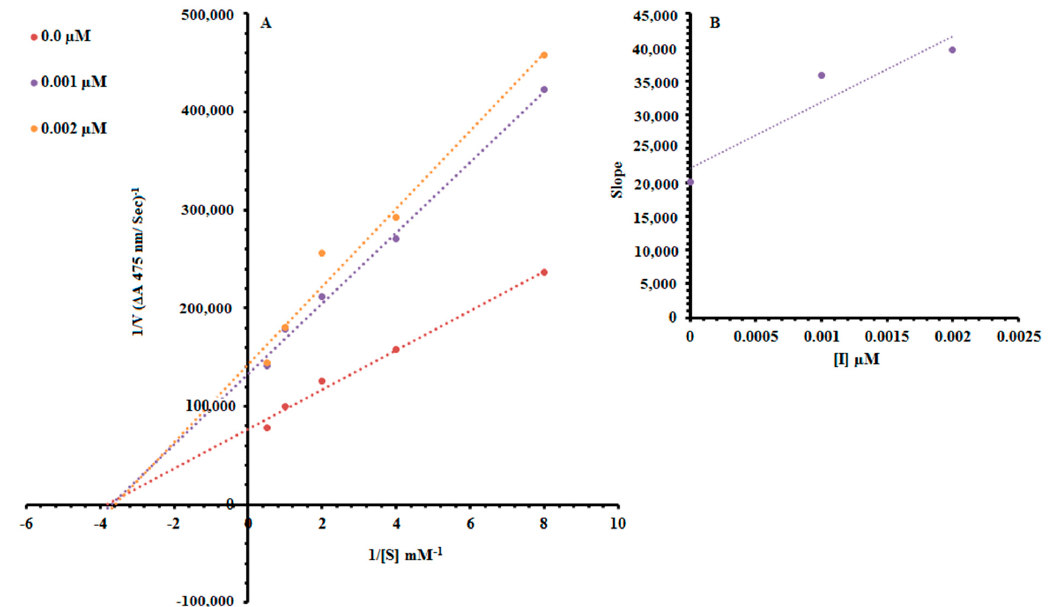
Figure 2. Lineweaver–Burk plots for inhibition of tyrosinase in the presence of 2-((4-methoxyphenethyl)amino)-2-oxoethyl cinnamate (Ph6). ( A ) Concentrations of Ph6 were 0, 0.001 and 0.002 µ M, respectively. Substrate L -DOPA concentrations were 0.125, 0.25, 0.5, 1 and 2 mM, respectively. ( B ) The insets represent the plot of the slope. The lines were drawn using linear least-squares fit.